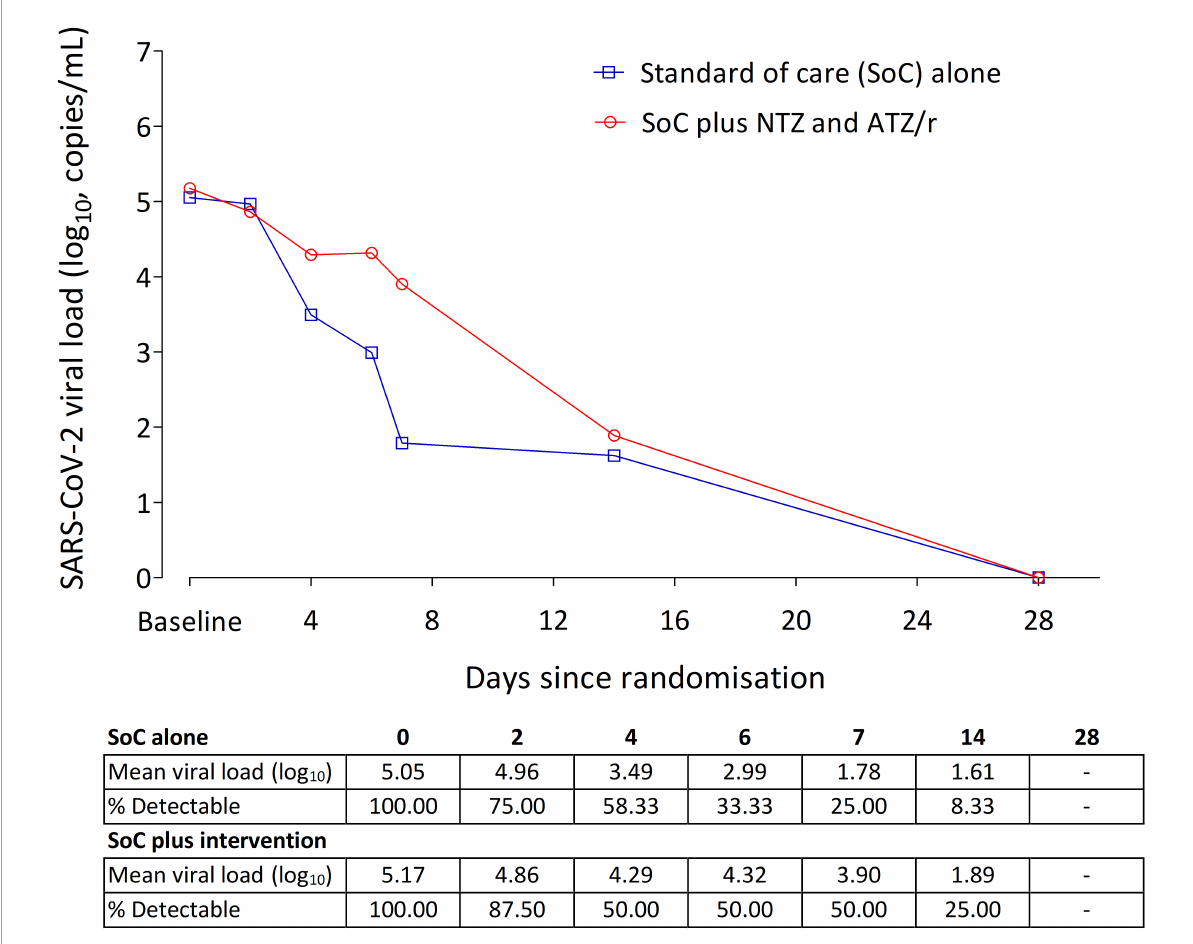
FIGURE3 Changes in SARS-CoV-2 viral load in saliva of patients from enrollment to study day 28. In the 20 patients with detectable saliva viral load at enrollment, baseline viral load was 5.05 log10 copies/ml in the SoC alone arm ( n = 12), and 5.17 log10 copies/ml in the SoC plus intervention arm ( n = 8). In this small cohort, there was no difference in the rate of viral load decline between the two arms (Cox proportional hazards model aHR = 0.948, 95% Cl: 0.341–2.636, p =